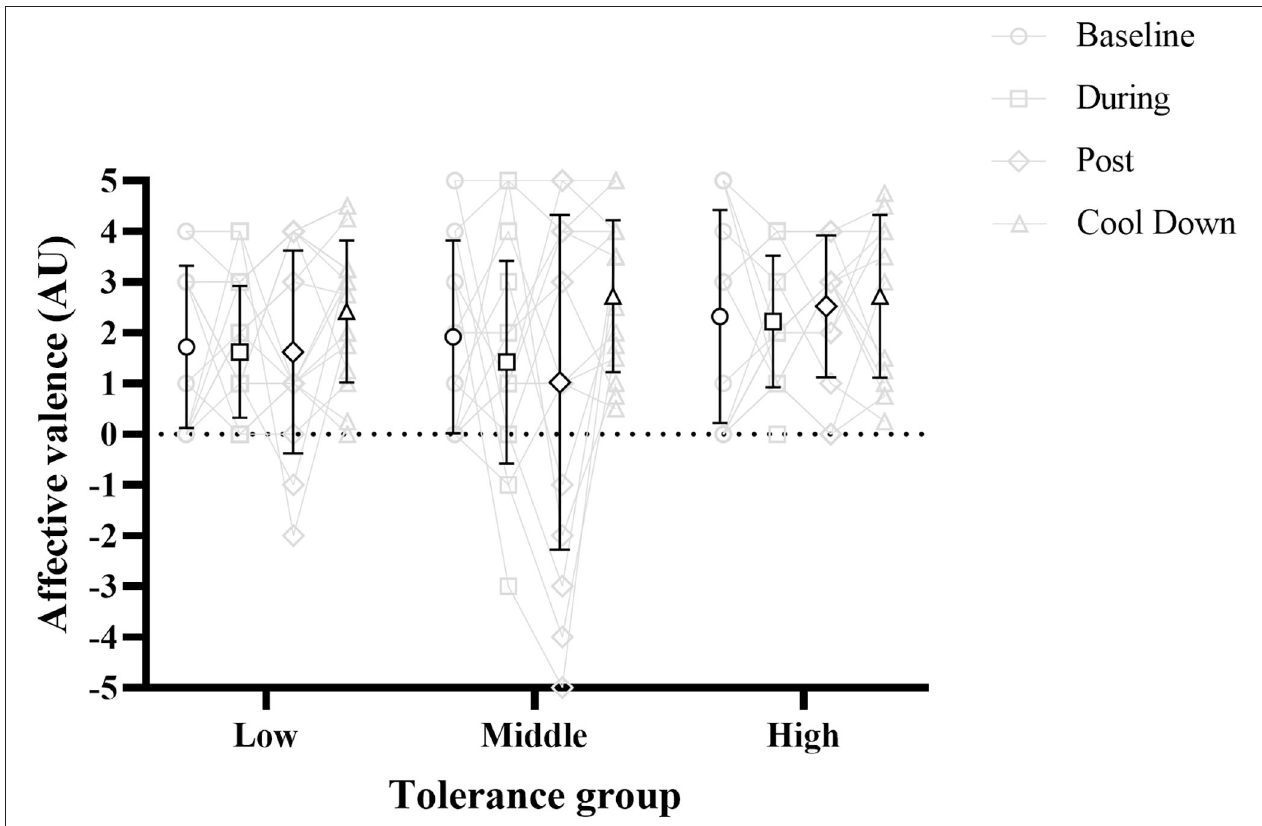
FIGURE 4 | Affective valence at each time point for all tolerance groups. Symbols with black outline are mean, with error bars representing standard deviation. Data in gray is individual participant data. Gray lines represent a single participant across each time